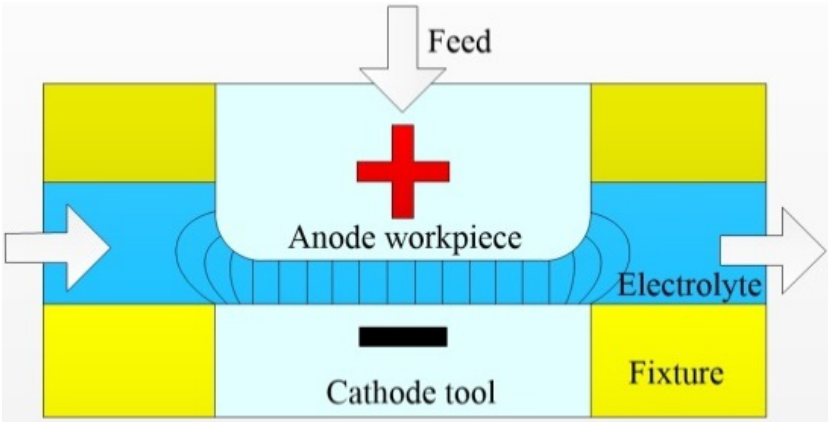
Figure 2. The electric field distribution in the conventional constant voltage method. To reduce the influence of both edge effects and stray current, this study proposes a current efficiency curve measurement with a casing-type anode. Figure 3 shows the schematic diagram of the measurement setup with a casing-type anode. In this method, the target material is divided into two parts: the mandril and the casing. There is a small gap between the mandril and the casing to ensure that the mandril and the casing do not conduct directly. The electric field at the end of the mandril is less affected by the stray current and the edge because of the shielding effect of the casing, and thus, the current density distribution on the end of the mandril can be considered uniform.